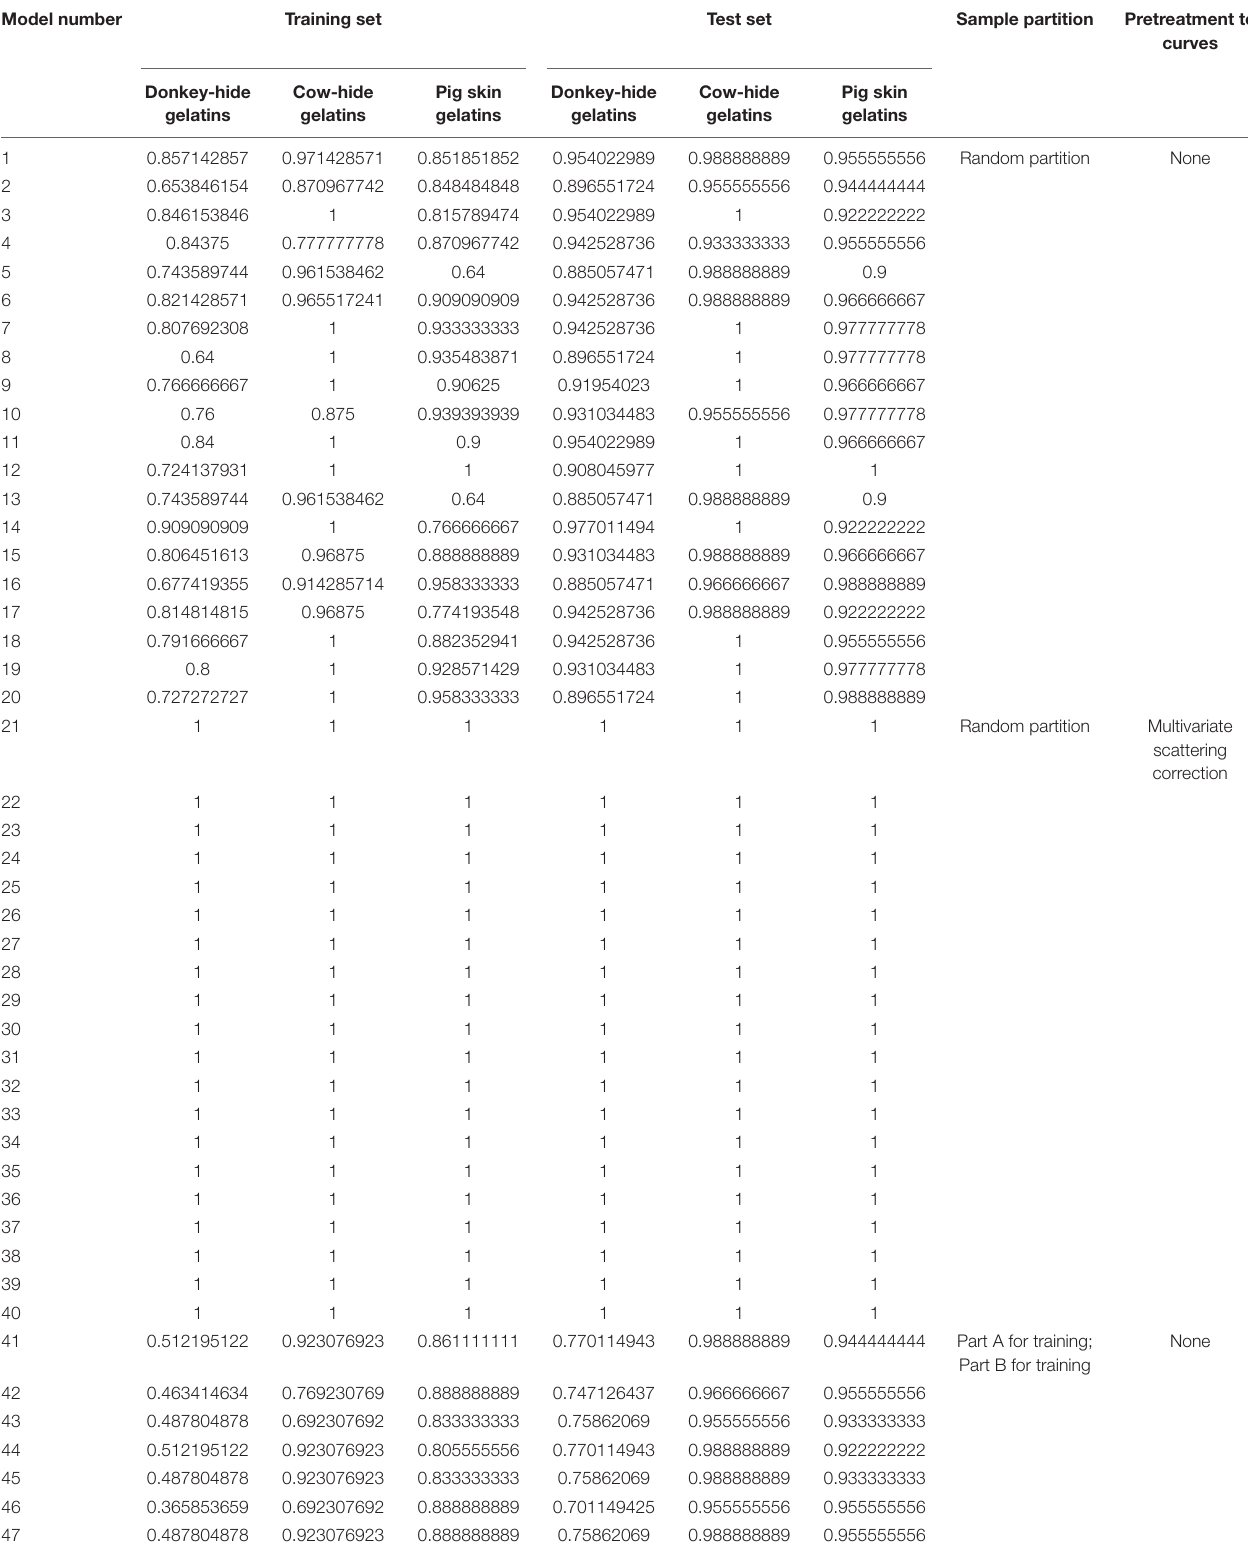
TABLE 1 | Accuracy of predictions for models which differ in initialization, sample partition and the samples for training. Model number Training